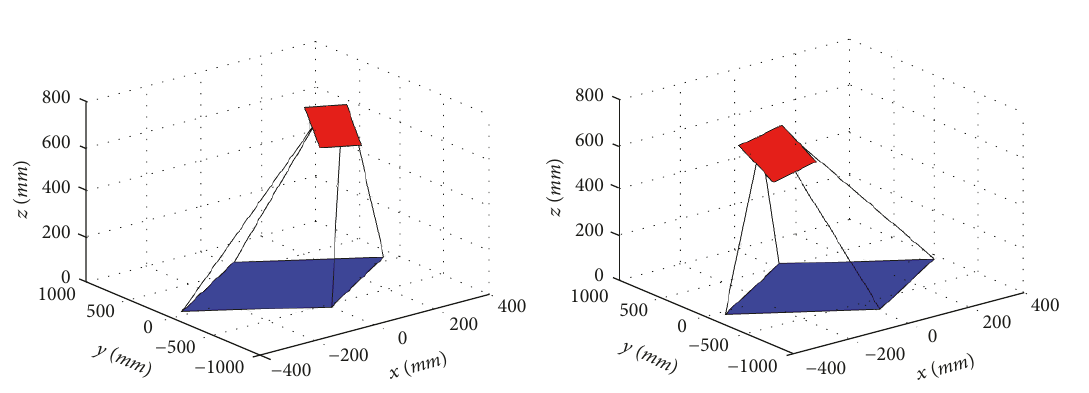
Figure 5: Different configurations for forward position.